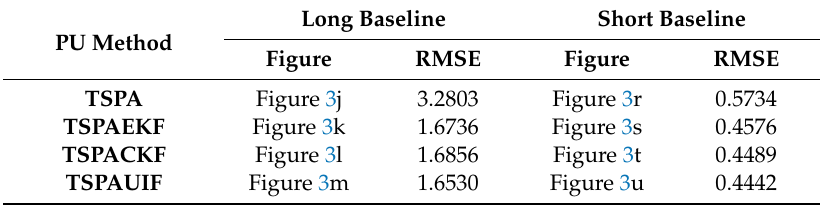
Table 2. The results of different PU methods in Figure 3(j–m,r–u) (unit: radians).